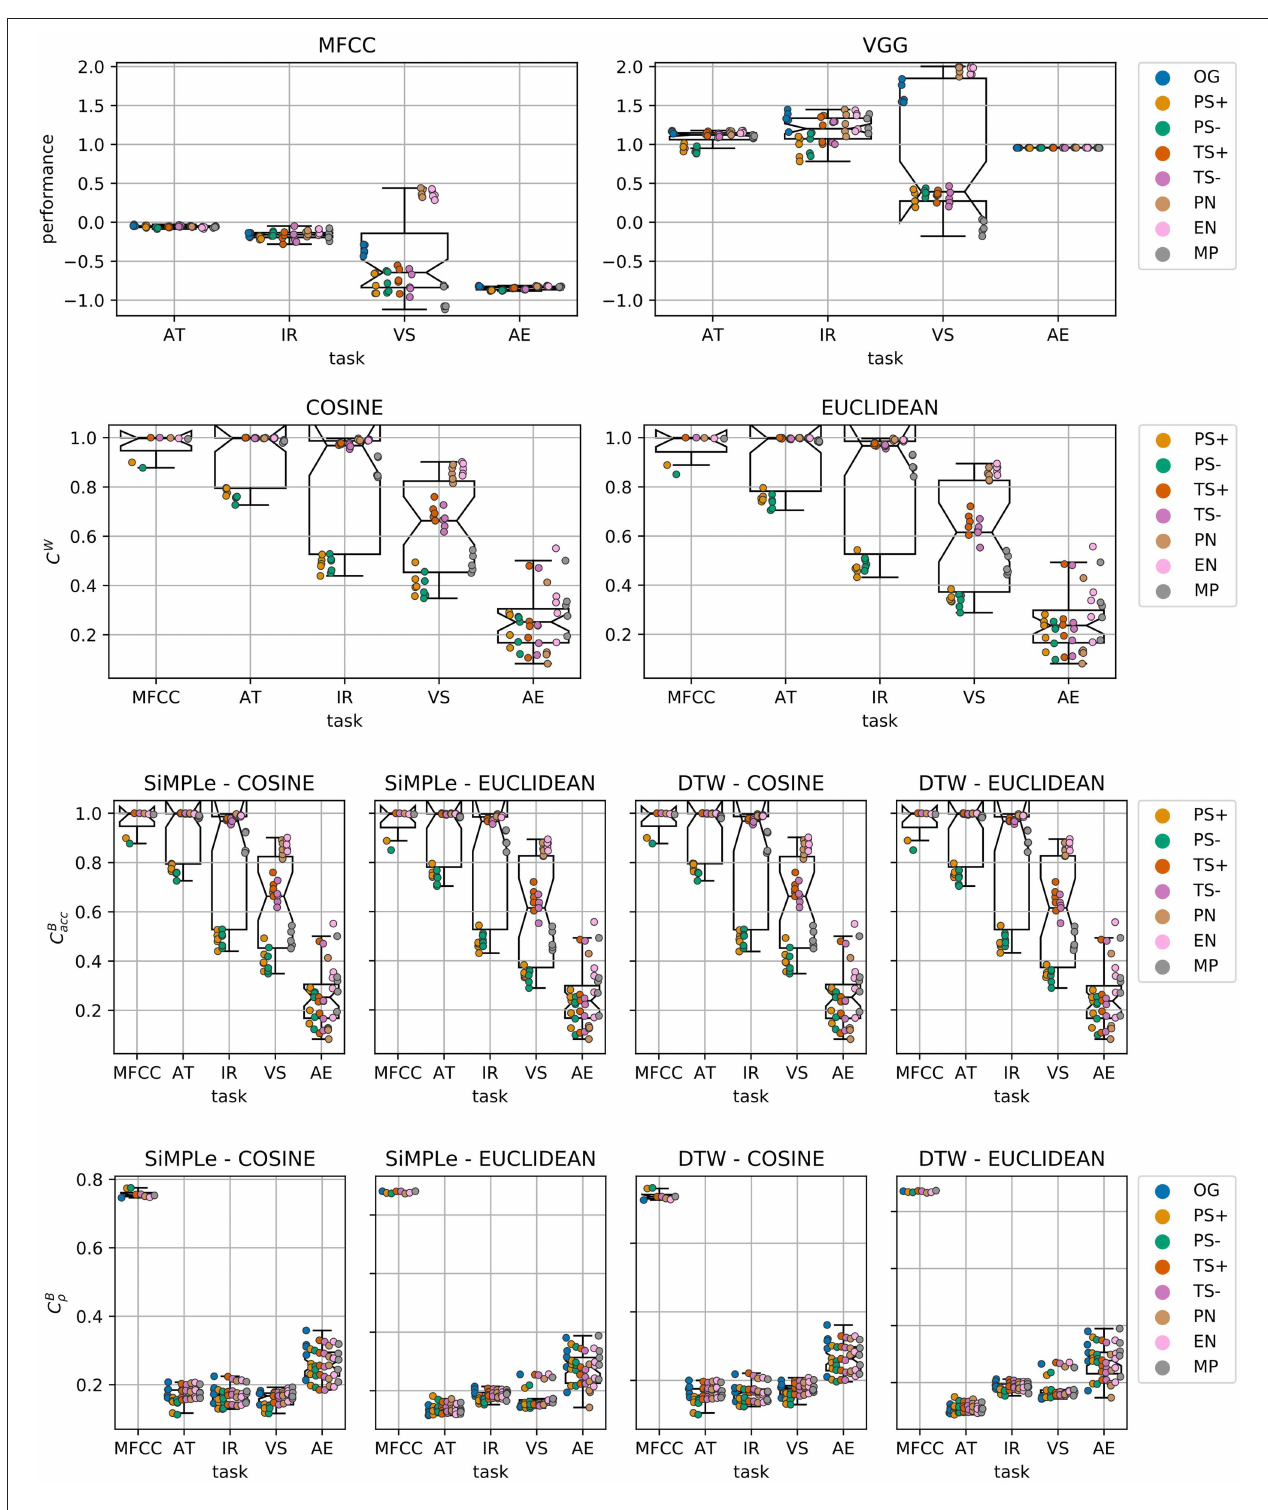
FIGURE 12 | Performance, within-space consistency, and between-space consistency distribution on the minimum transformations. The points are individual observations with respect to the transformation types. For PS and TS, we distinguish in the direction of the transformation (+: pitch/tempo up, -: pitch/tempo down). The first row indicates the task-specific performance, and the second row depicts the within-space consistency C W , and finally, the third and fourth rows show the between-space consistency C B acc and C B ρ , respectively. The performance is standardized per task, and the sign of AE performance is flipped, similarly to our analysis models.